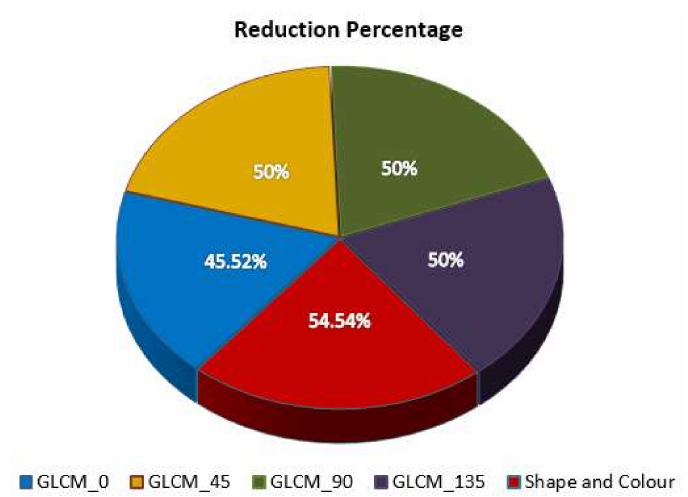
Figure 5. Reduction percentage for various IDSSDRP.